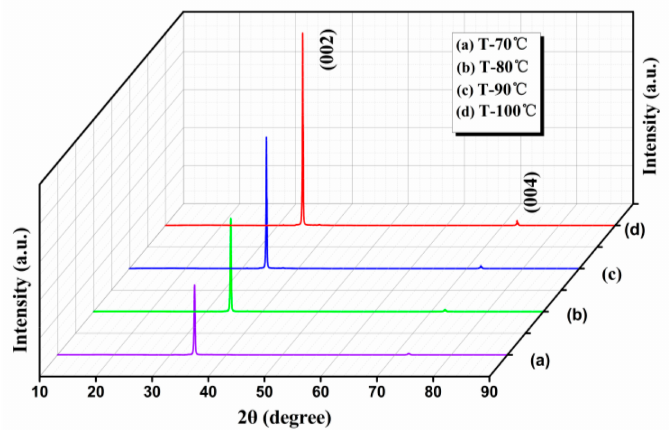
Figure 1. XRD patterns of all the Al-doped ZnO (AZO)